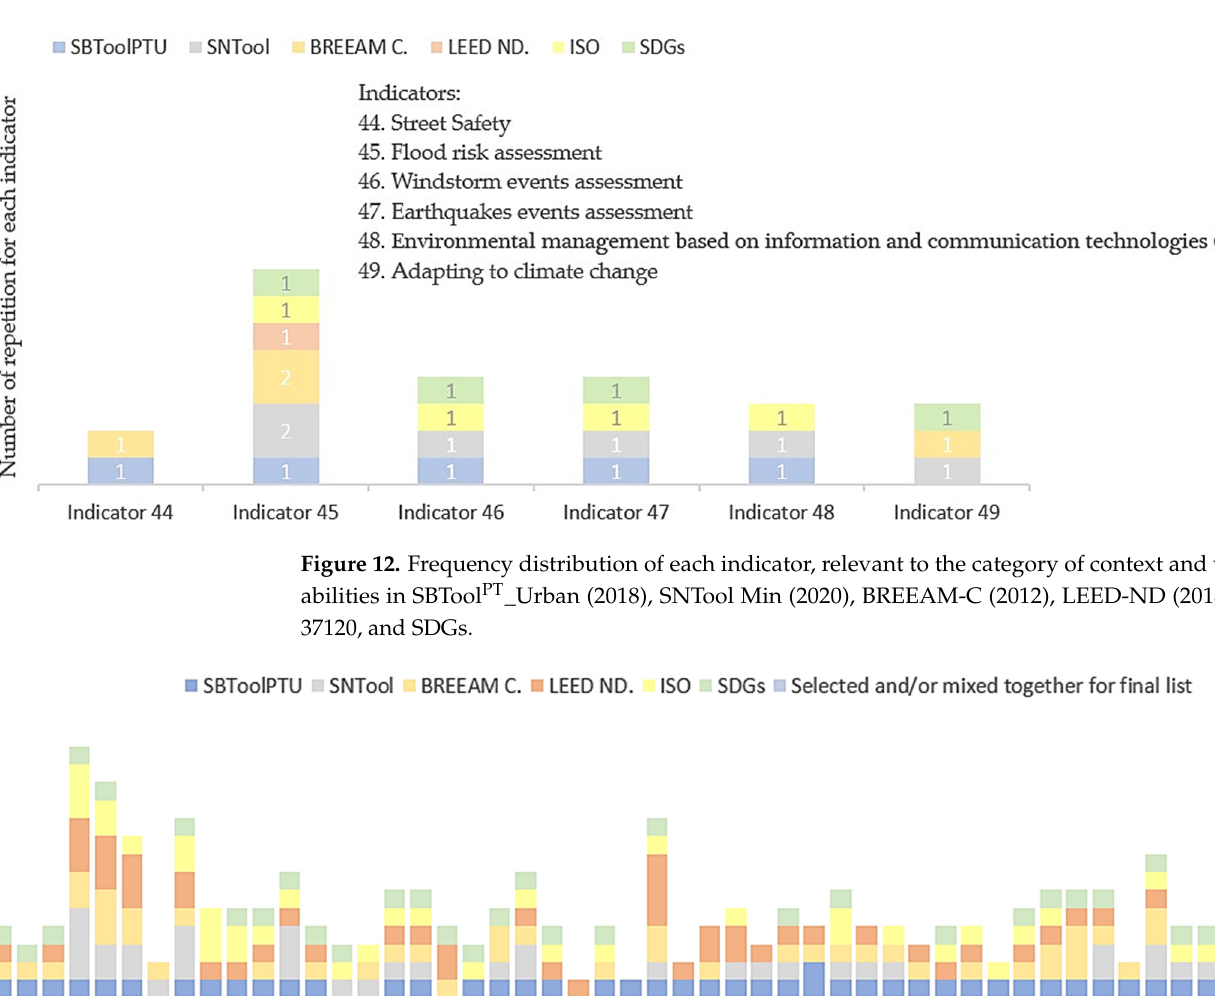
Figure 11. Frequency distribution of each indicator, relevant to the category of local and cultural identity in SBTool PT _Urban (2018), SNTool Min (2020), BREEAM-C (2012), LEED-ND (2018), ISO 37120, and SDGs.